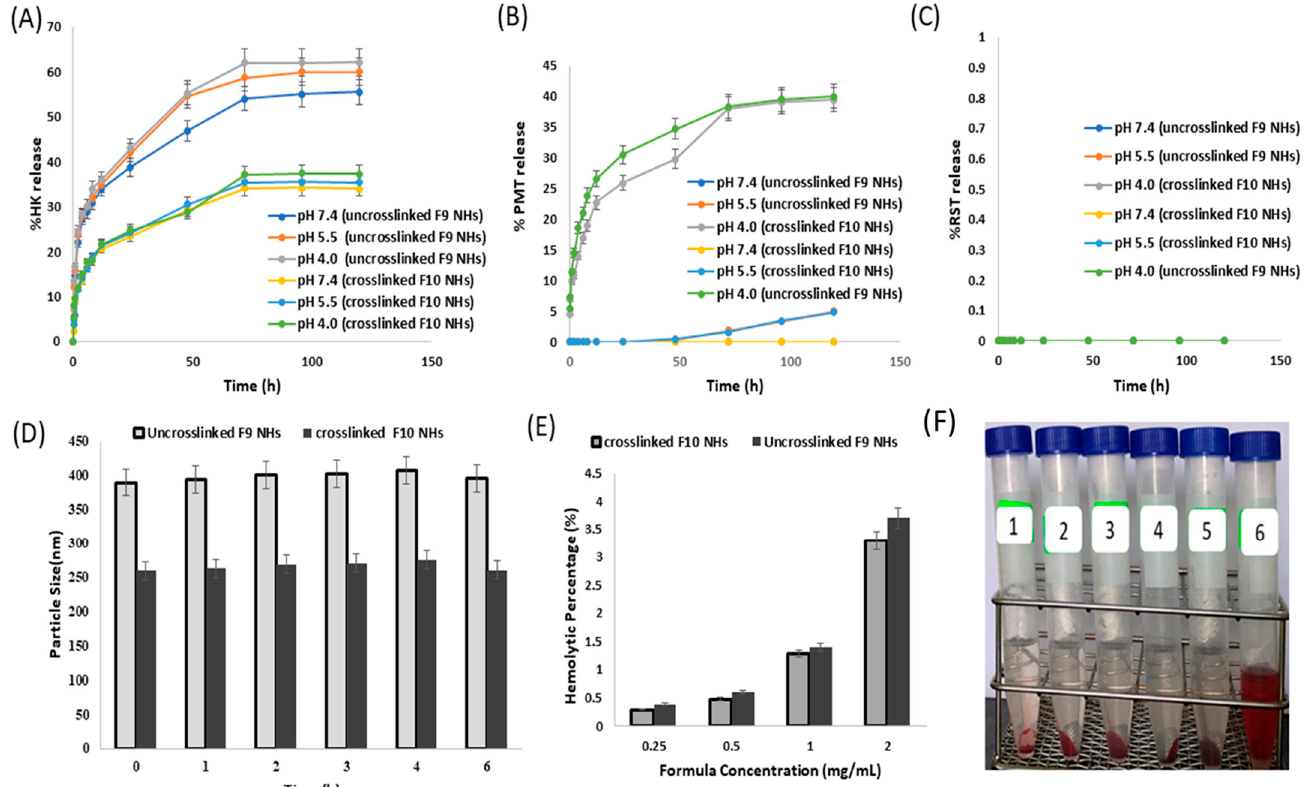
Figure 5. ( A ) In vitro drug release of HK from uncrosslinked F9 and crosslinked F10 NHs; ( B ) PMT from F9 and F10 NHs ( n = 3); ( C ) RST from F9 and F10 NHs ( n = 3); ( D ) serum stability of F9 and F10 NHs ( n = 3); ( E ) hemolytic effect of F9 and F10 NHs ( n = 3); ( F ) image of hemocompatibility at 37 °C with RBCs after 1 h of incubation.